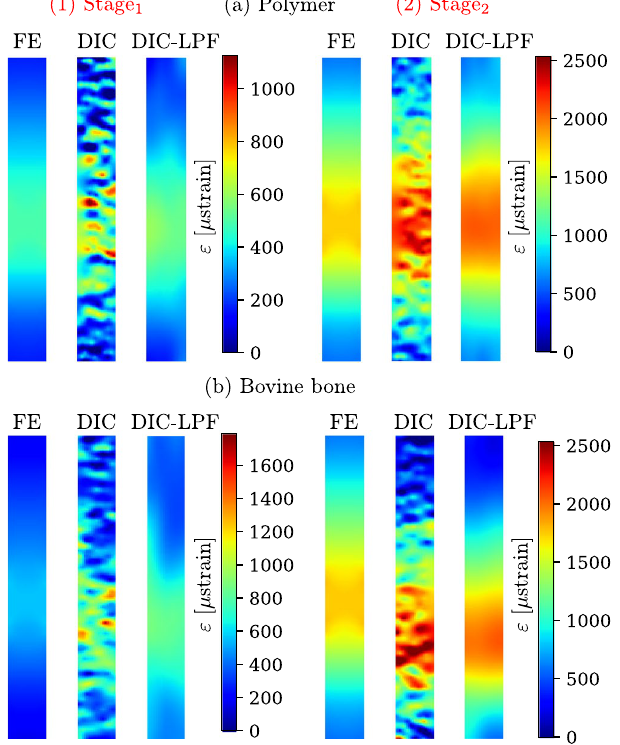
specimen, the DIC strains (original and filtered) are